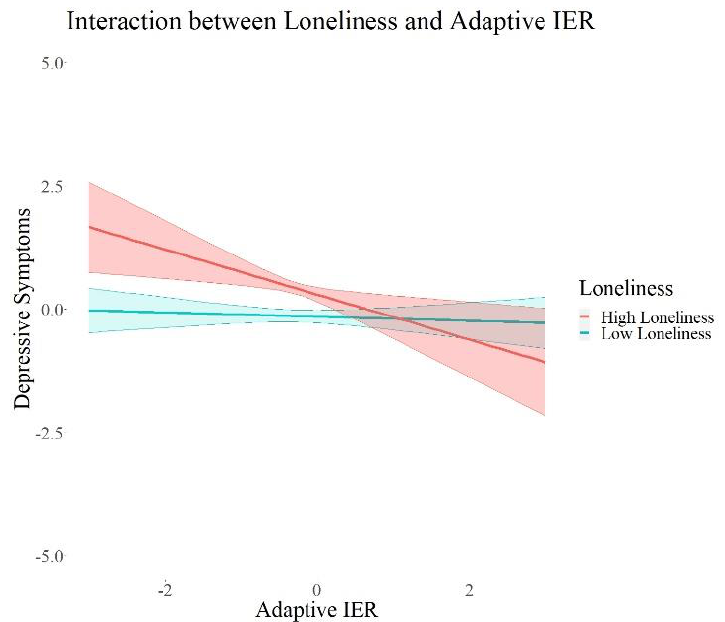
Figure 2. Interaction Effects between Loneliness and Adaptive IER on Depressive Symptoms. Note . The shades behind the thicker lines represent the 95% confidence interval. All variables were standardized, and the scales on the graph represent standard deviations (i.e., 2 = 2 units of standard deviation).